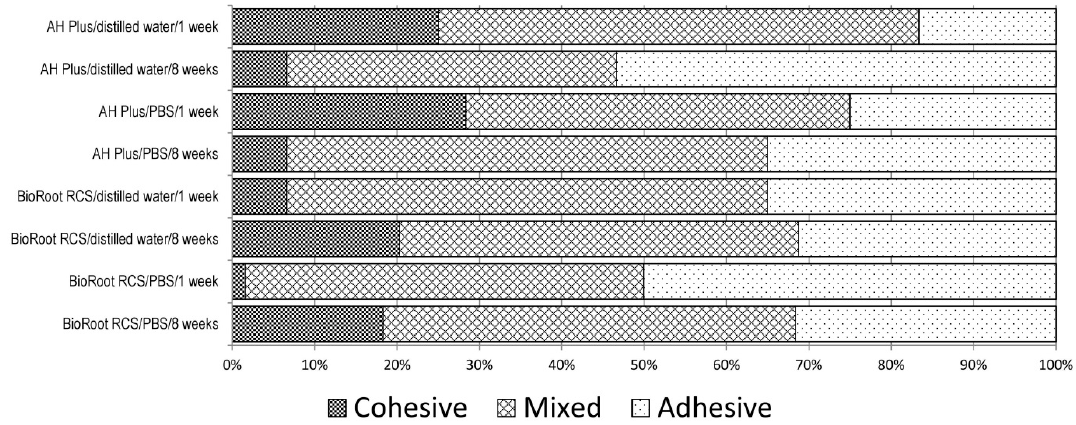
Figure 1. Percentage distribution of failure modes in all groups (%).